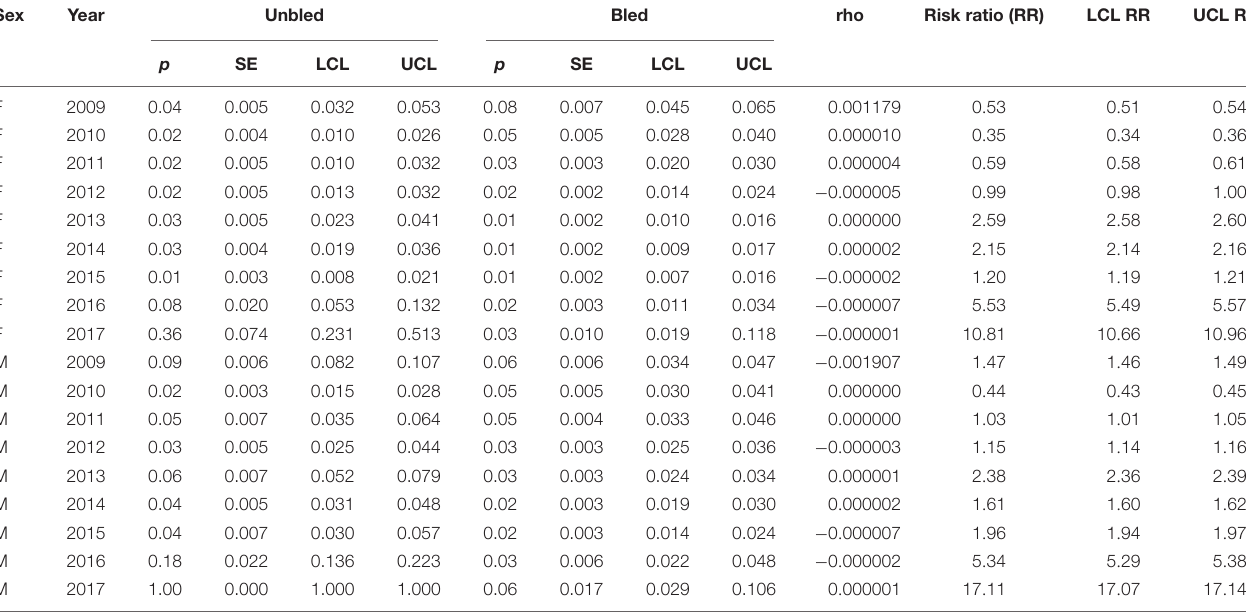
TABLE 8 | Capture probability ( p ) for the top model for tagged horseshoe crabs released in coastal Delaware to Virginia from 2008 to 2017. Sex Unbled